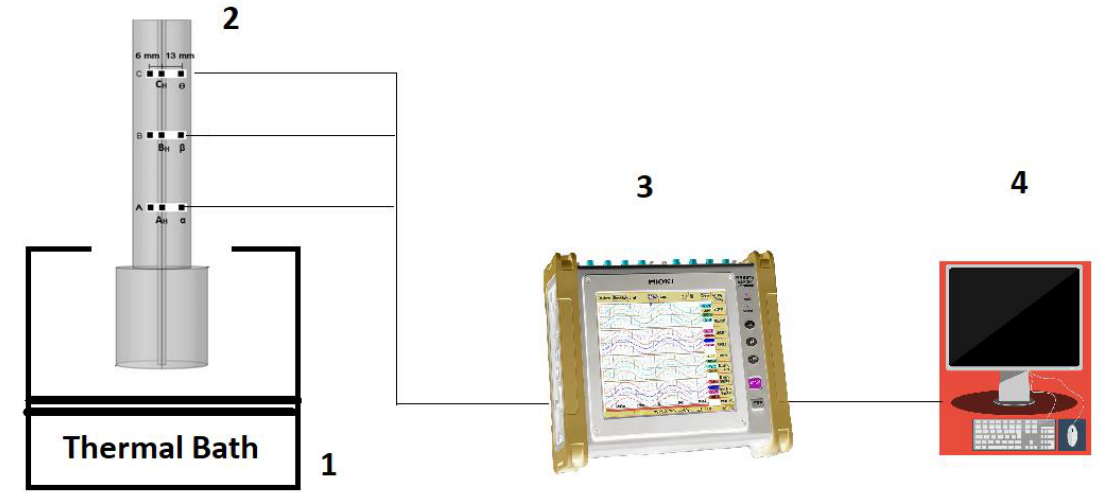
Figure 2. Schematic diagram of the experimental system. ( 1 ) Water bath, ( 2 ) test rig, ( 3 ) data logger, and ( 4 ) personal computer. Table 1. The important properties of the heat pipe.